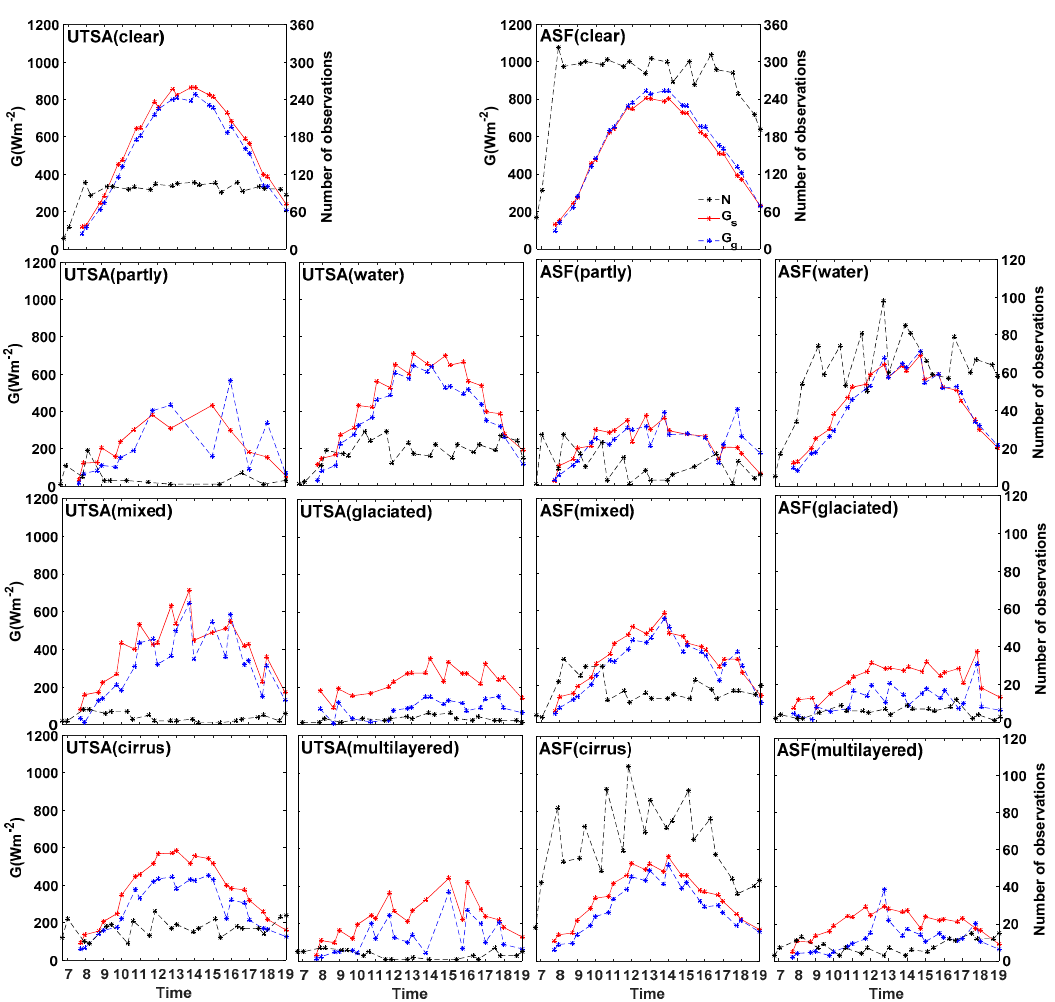
Figure 2. Mean hourly surface solar irradiance G s (red solid) and G g (blue dash) and total number of pairs (black dash) plotted against the time of day (hours) for clear-sky and cloudy-sky conditions, during the respective time periods: 1 May–25 October 2015 at the UTSA site ( left two panels ) and July–September 2014 and 22 September 2015–18 October 2016 at the ASF site ( right two panels ).